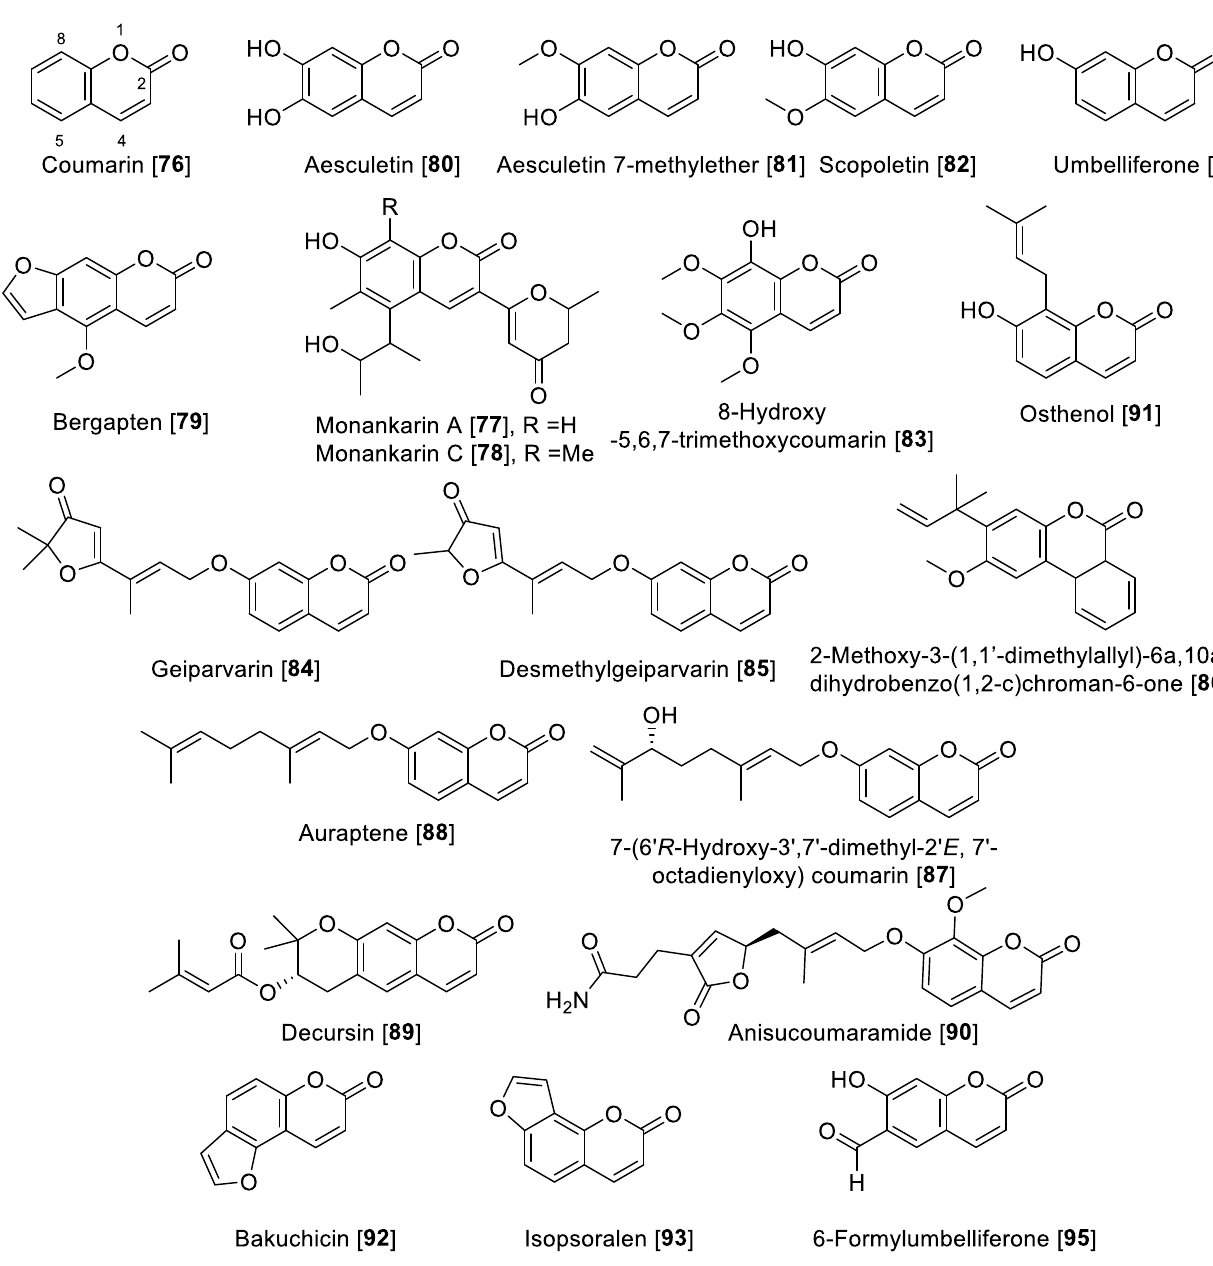
Figure 9. Chemical structure of selected coumarin MAO inhibitors.